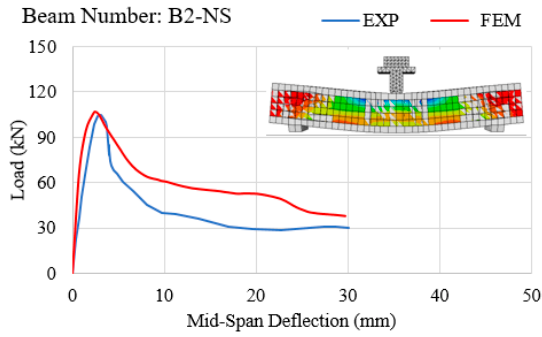
Figure 14. Load vs. mid-span deflection for C-NS.